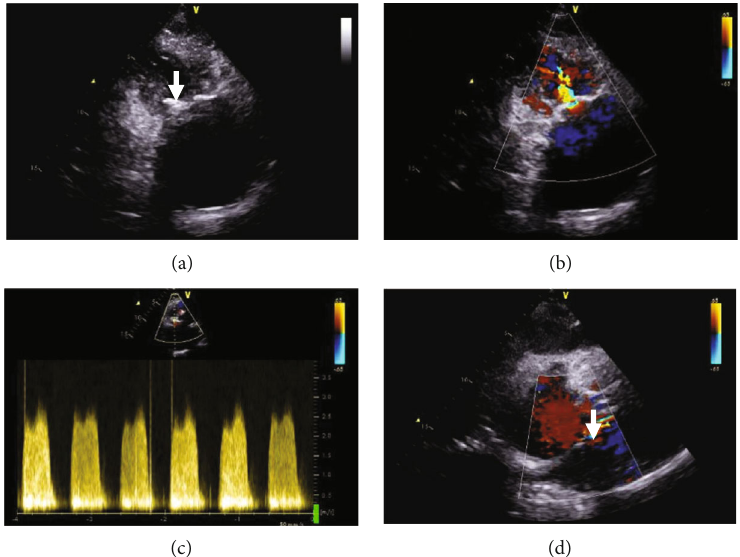
Figure 1: Transthoracic echocardiography (TTE) and Doppler before the operation: bioprosthetic tricuspid valve calci fi cation (white arrow) and stenosis (a, b). Bioprosthetic maximal velocity 2.7m/s (c). The foramen ovale opening (white arrow) (d).